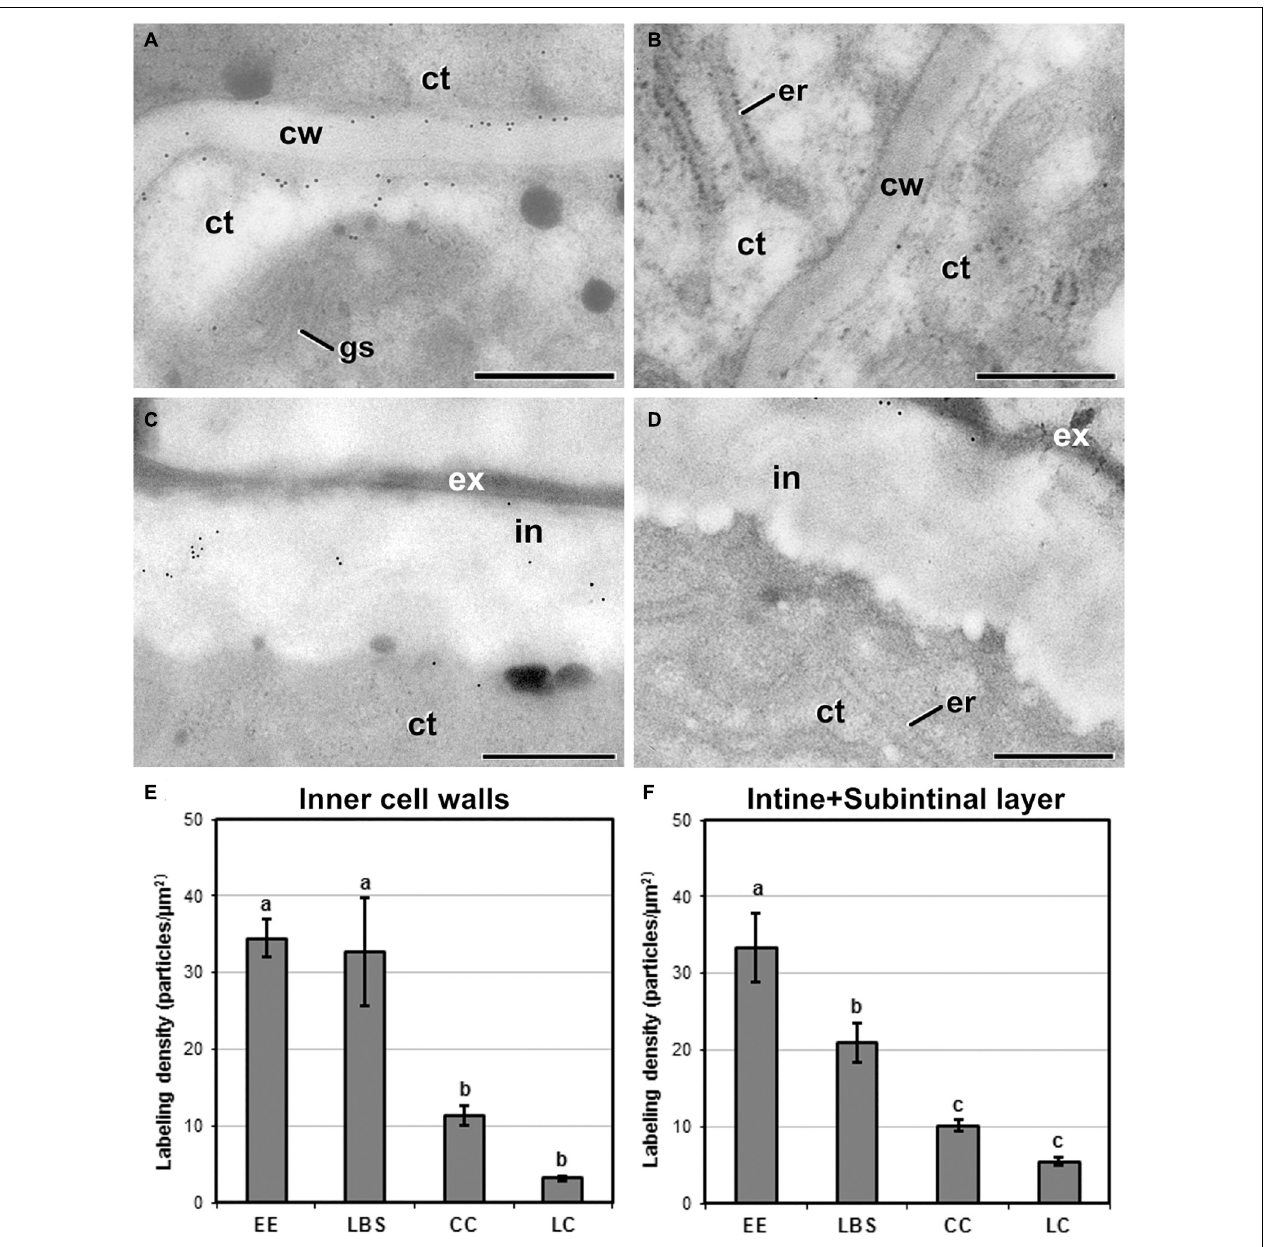
FIGURE 5 | Detection of JIM13 cross-reacting AGPs by immunogold labeling and quantification in TEM images of 5-day-old microspore cultures. Inner cell wall images of EE (A) and LC structures (B) . Outer cell wall (intine + subintinal layer) images of EE (C) and CC structures (D) . (E) Quantification of JIM13-cross-reacting AGPs in inner cell walls. (F) Quantification of JIM13-cross-reacting AGPs in outer cell walls (intine + subintinal layer). Labeling density is expressed as number of particles/ µ m 2 . Different letters represent significant differences according to the LSD test. ct, cytoplasm; cw, cell wall; er, endoplasmic reticulum; ex, exine; gs, Golgi stack; in, intine; m, mitochondria; v, vacuole. Bars: 500